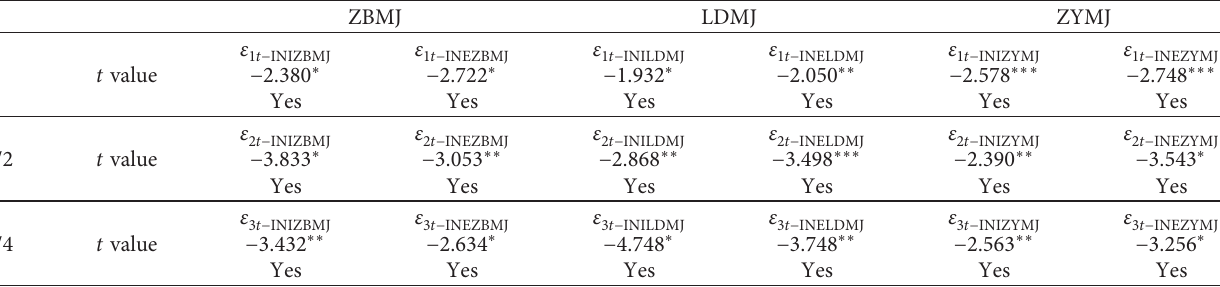
Table 4: Tests on the 0, 1/2, and 1/4 frequency cointegration.